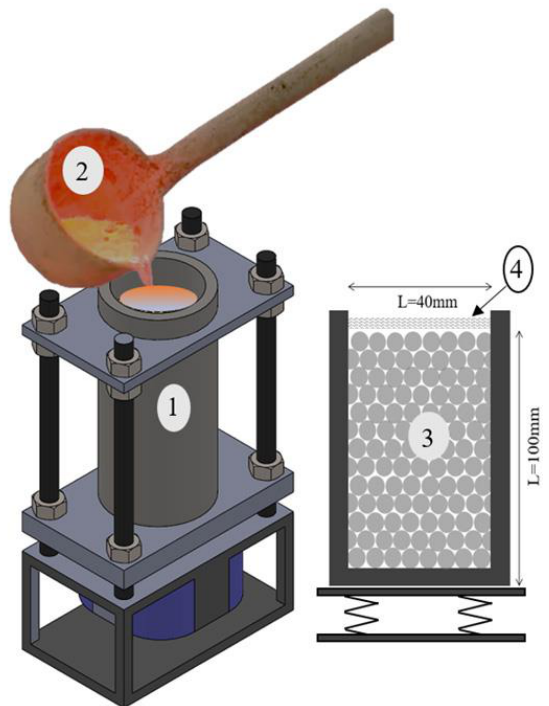
Figure 2. Composite production set-up. (1) Metallic mould; (2) aluminum alloy melt; (3) LECA particles; (4) steel net.